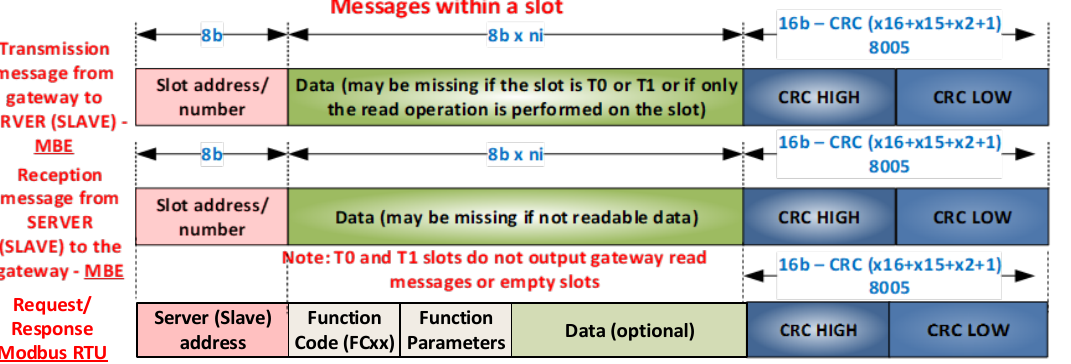
Figure 2. MBE; Modbus RTU messages.